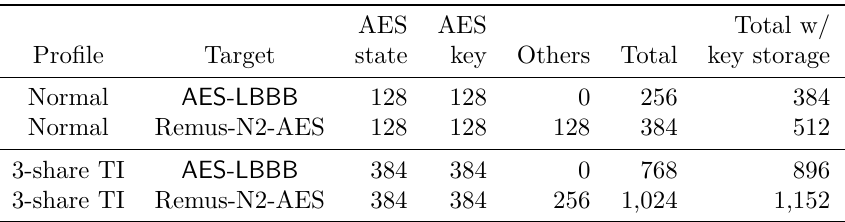
Table 2: Memory/register sizes in bits for AES - LBBB and Remus-N2-AES with and without threshold implementation